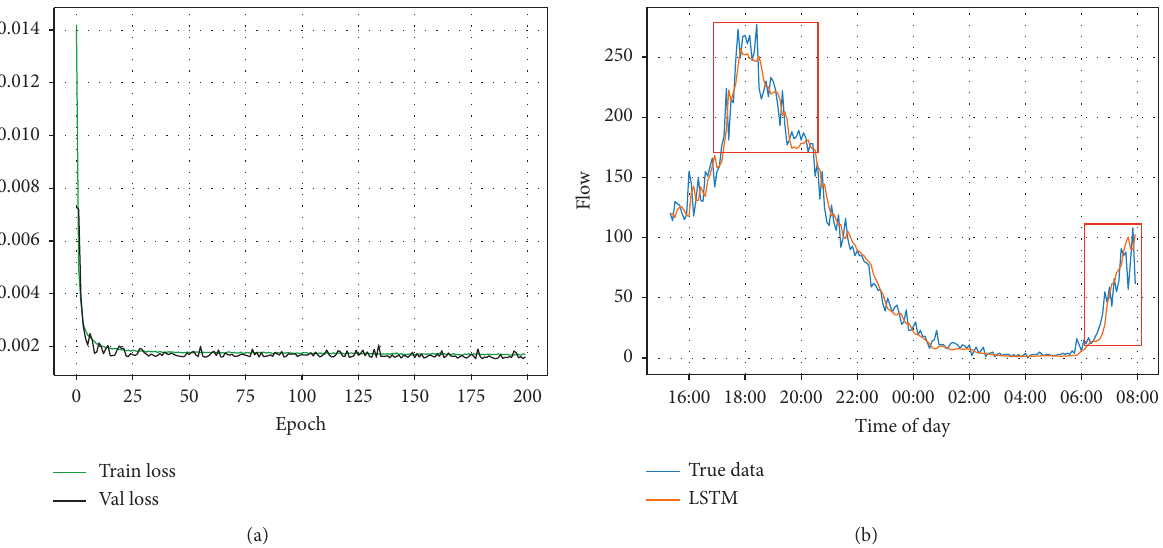
Figure 2: 5 min LSTM training and prediction. (a) 5min LSTM loss function and (b) 5 min LSTM prediction results.